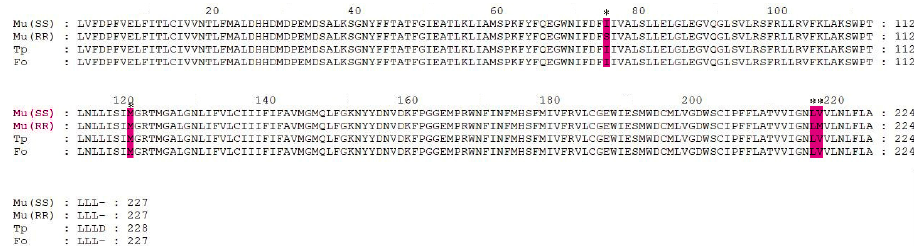
Figure A3. Multiple alignment between sodium channel domain II sequence without introns of M.